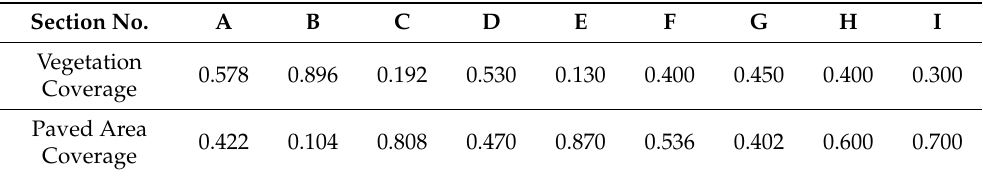
Table 1. Vegetation coverage, and paved area coverage of each section.